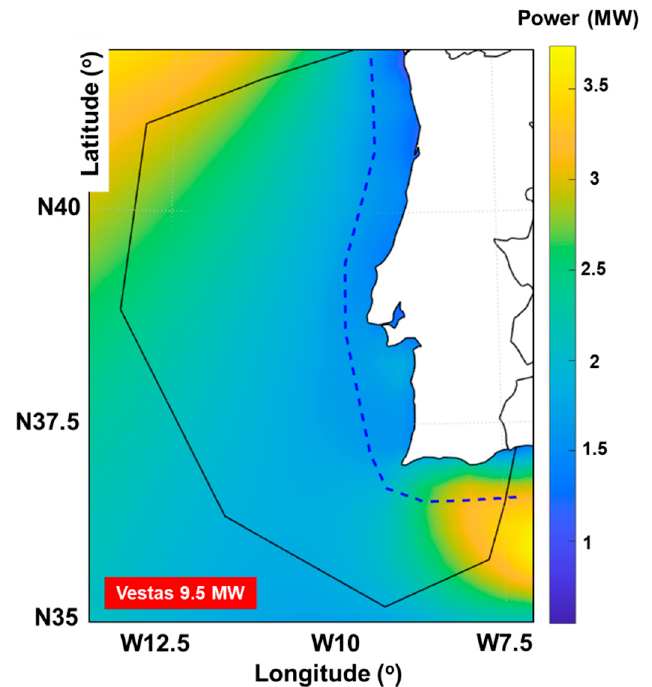
Figure 11. Expected power output (average) from the offshore wind turbine Vestas V164-9.5 MW ( U 100